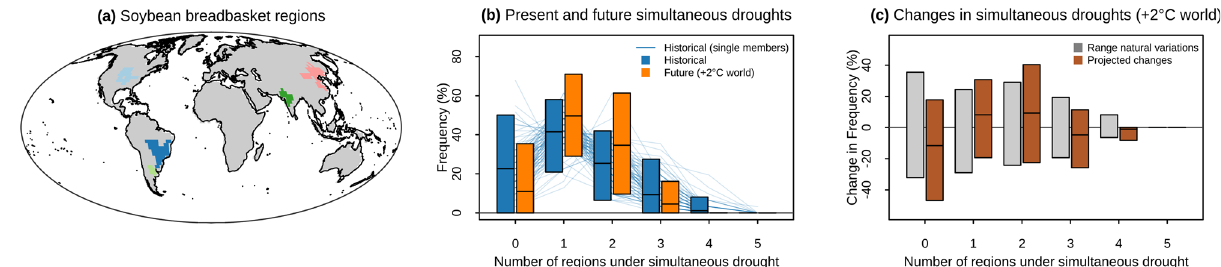
Fig. 5 | Internal climate variability can obscure forced changes in compound events. a The fi ve soybean regions. b Historical (blue) and future (orange) fre- quency of annual soil moisture drought (de fi ned as events occurring every 4years onaverage)occurringin N simultaneous( x -axis)soybeanregions(basedonMPI-GE model). Coloured bars indicate the centred 95th percentile range and the mean amongst the ensemble members (historical probabilities based on individual